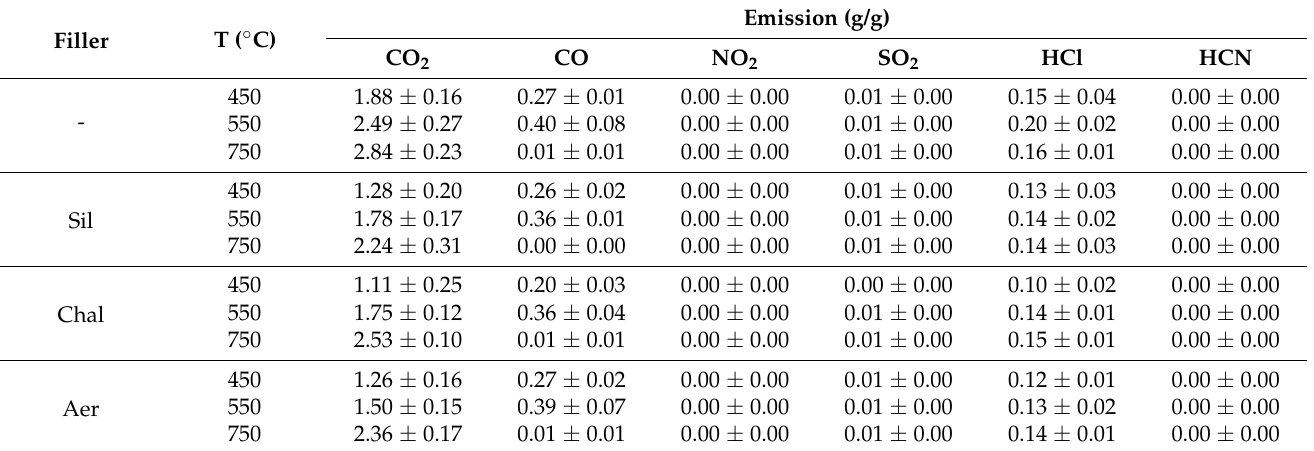
Table 5. Specific emission of selected, in accordance with the standard, gaseous products formed during the decomposition and combustion of unfilled and filled vulcanizates at the temperatures of 450, 550 and 750 ◦